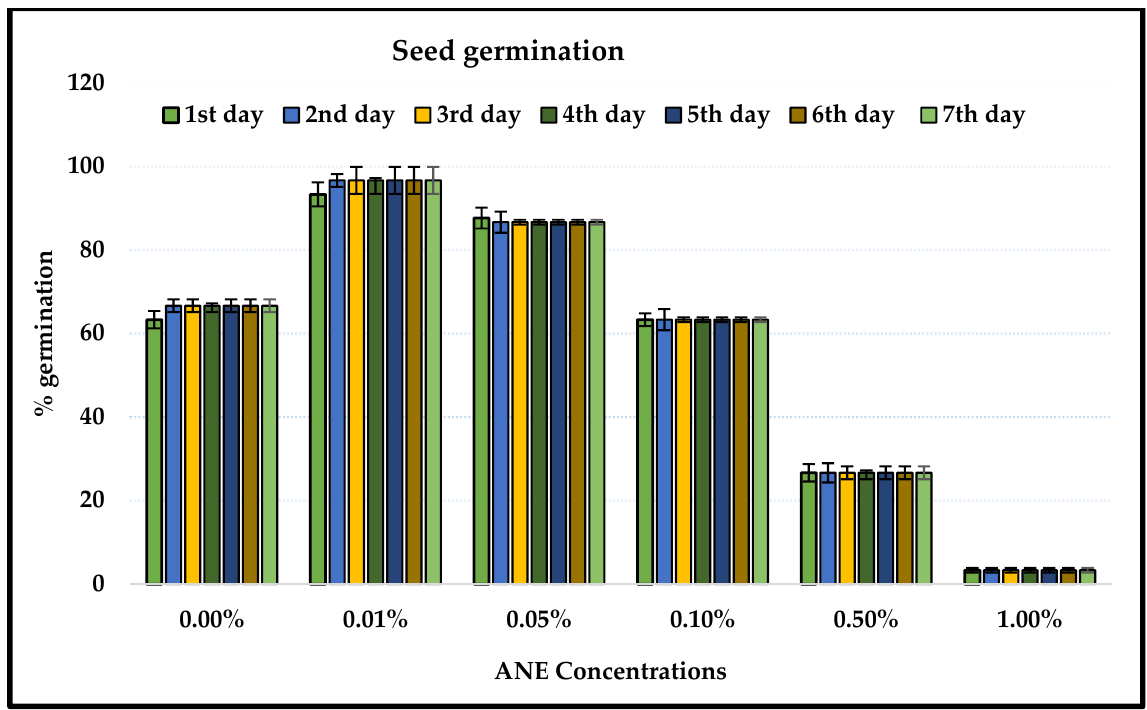
Figure 1. Seed germination of V. aconitifolia under different concentrations of A. nodosum . Bar indicates mean ± SD (n = 3).